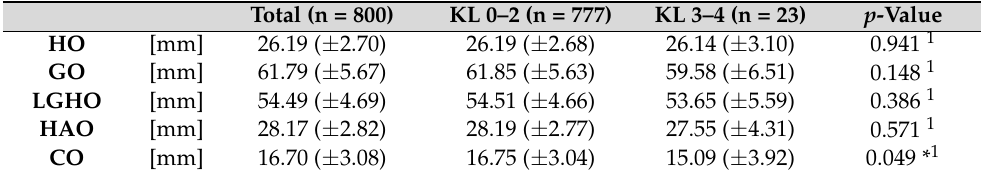
Table 4. Analysis of osteoarthritis-specific differences between offset parameters.